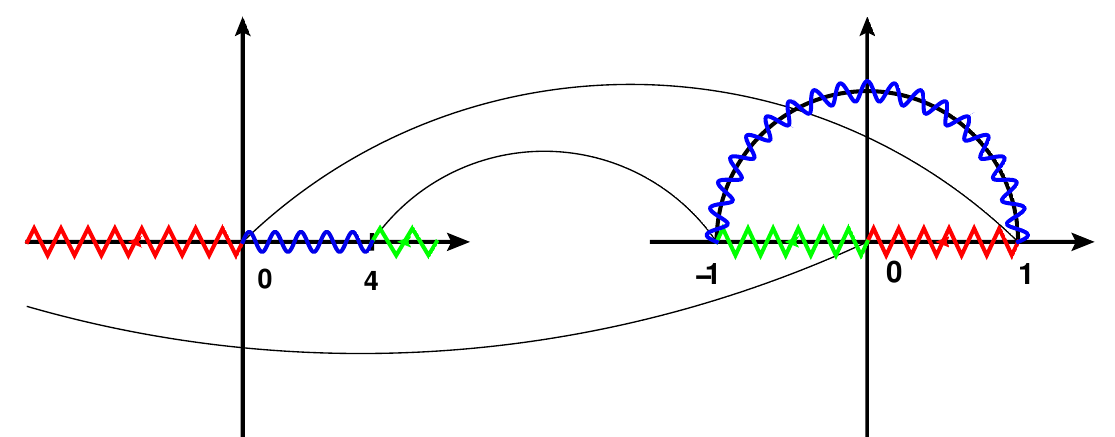
Figure 1. Illustration of the variable transformation between q 2 /m 2 and x as given in eq. (2.5). The left graph represents the q 2 /m 2 plane and on right the complex x plane is shown. The straight lines indicate the mapping for special values of q 2 /m 2 and x .